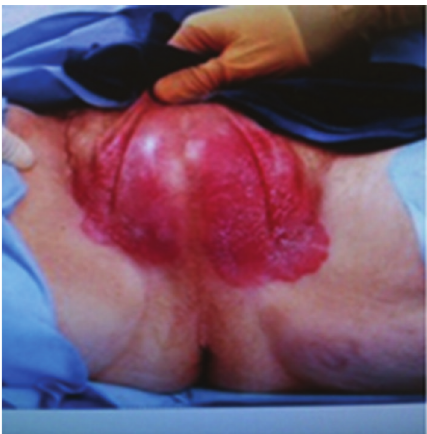
Figure 1: EMPD involving the scrotum and left thigh.